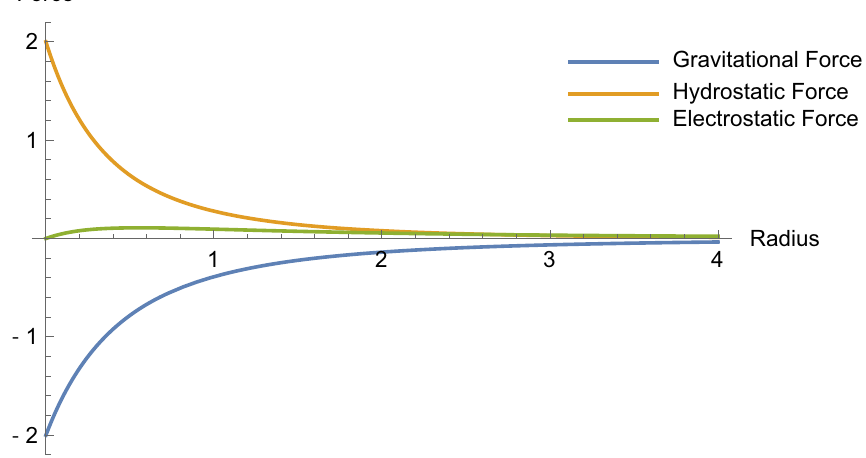
Fig. 10 Variation of forces in TOV-equation versus the radial variable